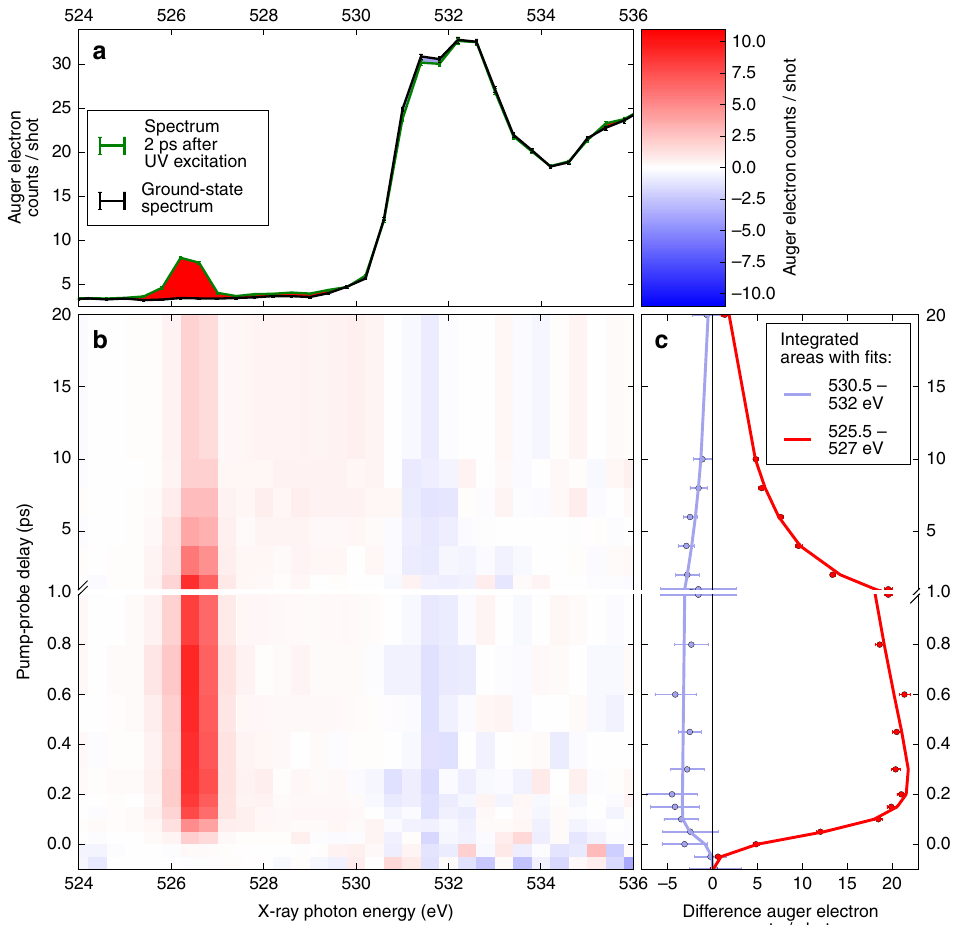
Fig. 2 Transient oxygen-edge absorption spectra of thymine. a Representative near-edge absorption fi ne structure (NEXAFS) spectra 2 ps after ultraviolet (UV) excitation and without UV excitation. UV-induced increase in intensity is marked red , UV-induced decrease is light blue . UV excitation leads to the appearance of a new spectral feature around 526.4 eV and a bleach of the ground state π * resonance at 531.4 eV. b False-color plot of time-dependent NEXAFS difference spectra (see color bar in the upper right corner). The UV-induced features at 526.4 and 531.4 eV are clearly visible throughout the positive pump-probe delays. c Time-dependence of the UV-induced features with fi ts based on a rate equation model. All error bars represent the standard error of